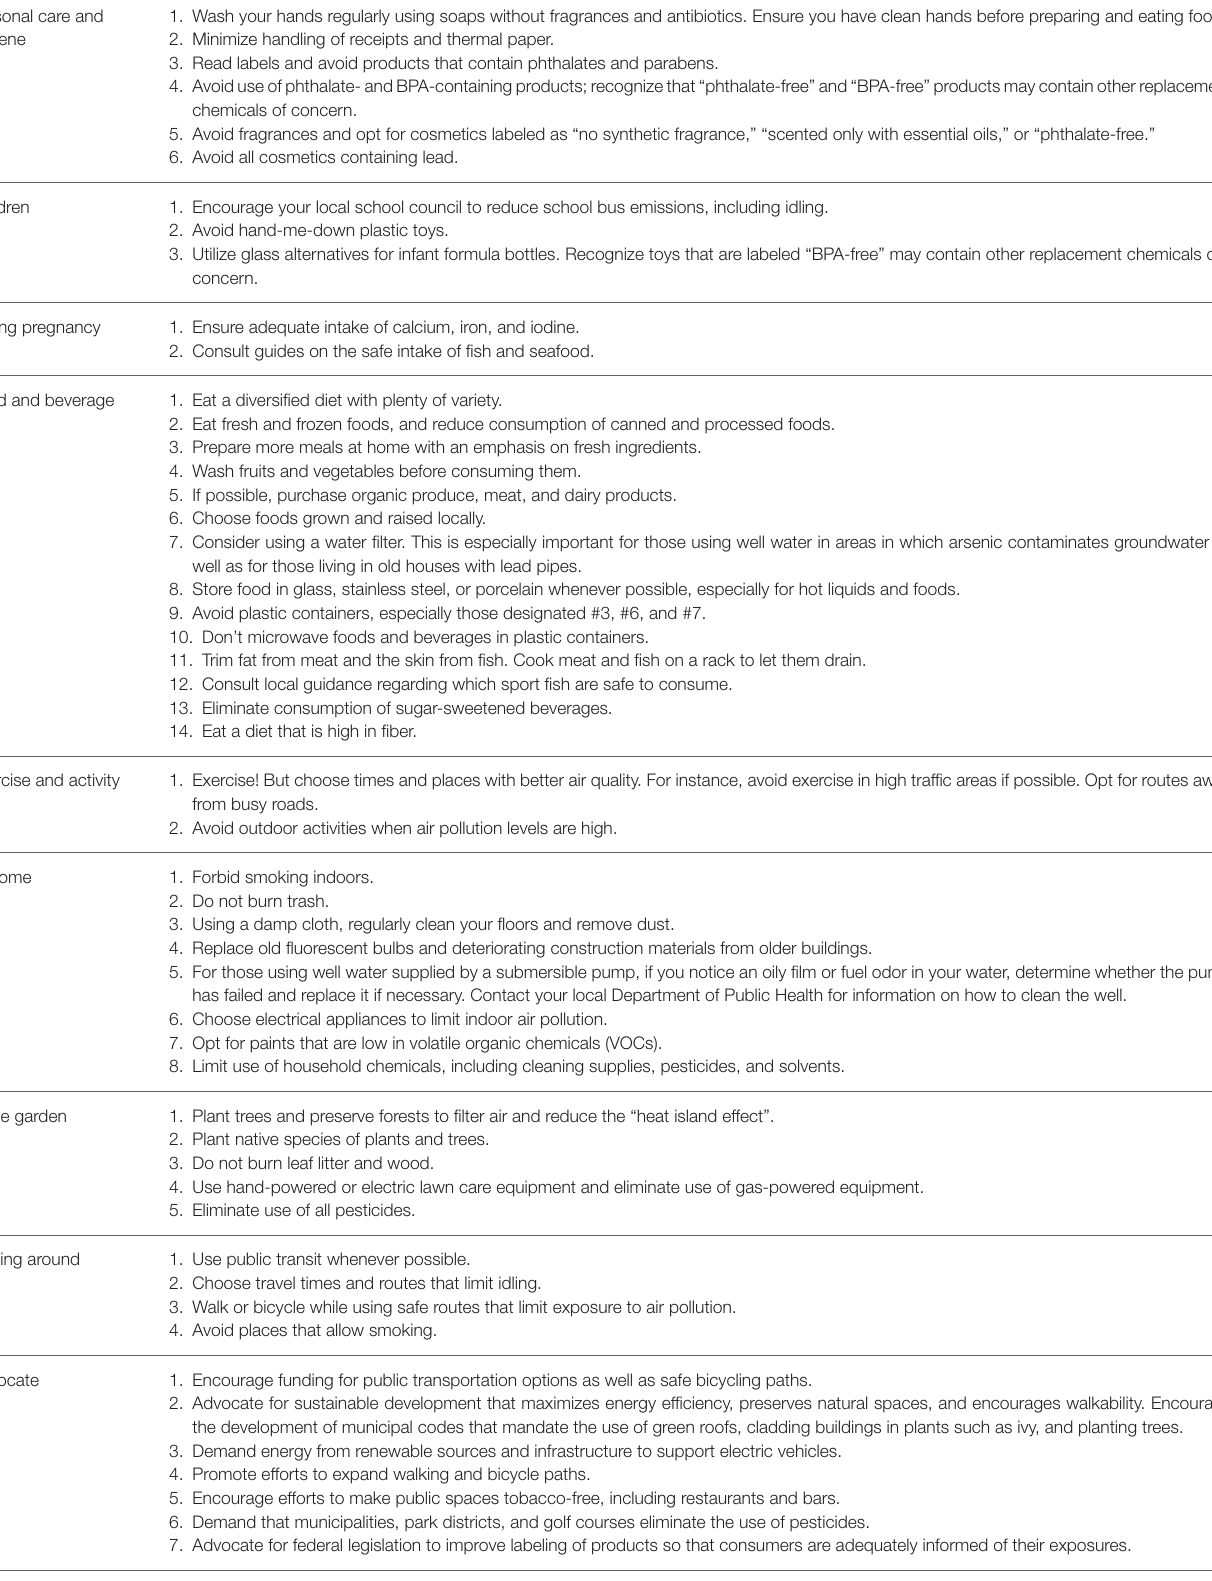
TABLE 1 | Interventions and resources to address exposures to metabolism-disrupting